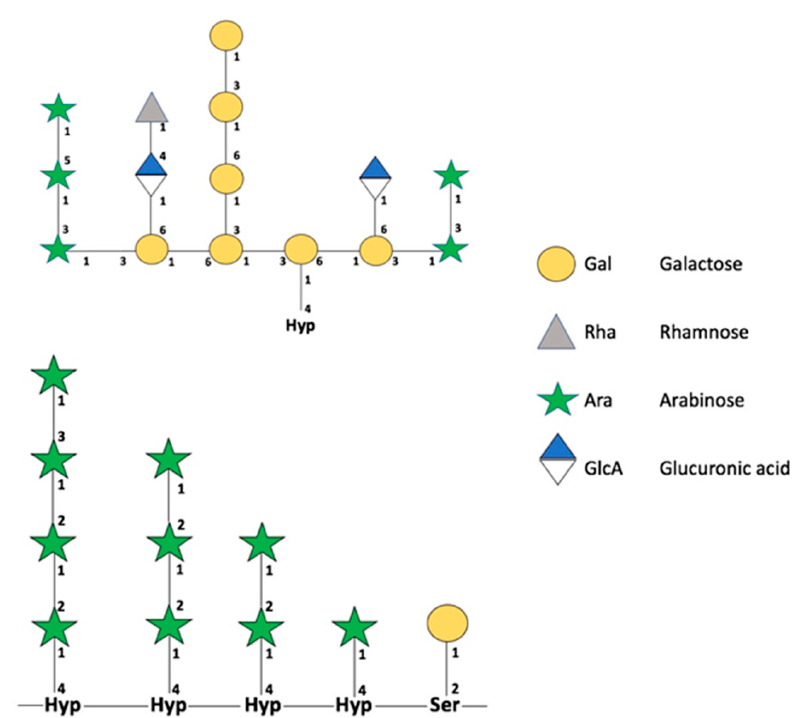
Figure 3. Schematic representation of O -glycans. The upper image summarizes the possible structures found in O -glycans in type II AGPs. The bottom image summarizes the possible O -glycosylations in plant EXTs. Representations of monosaccharides are based on the official notation of the Consortium for Functional Glycomics (CFG). Retrieved with modifications from Tan et al. [45] and Nguema-Ona et al. [46].